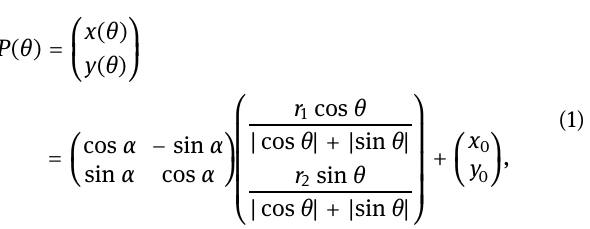
Figure 2: The rhombus that is deformation controlled and super - imposed on